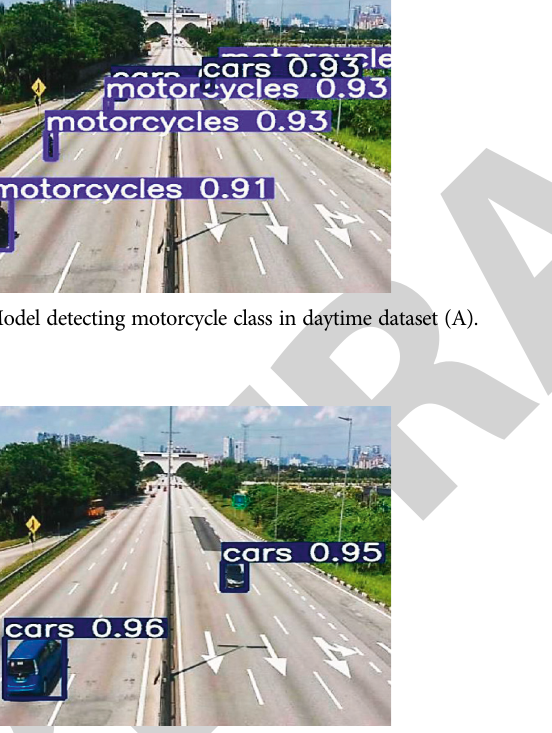
Figure 14: Model not being able to detect vehicles at small scale in daytime dataset (A).